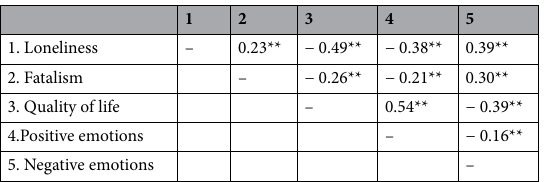
Table 2. Analysis of correlations between the variables of the model. **The correlation is significant at the 0.01 level (bilateral).